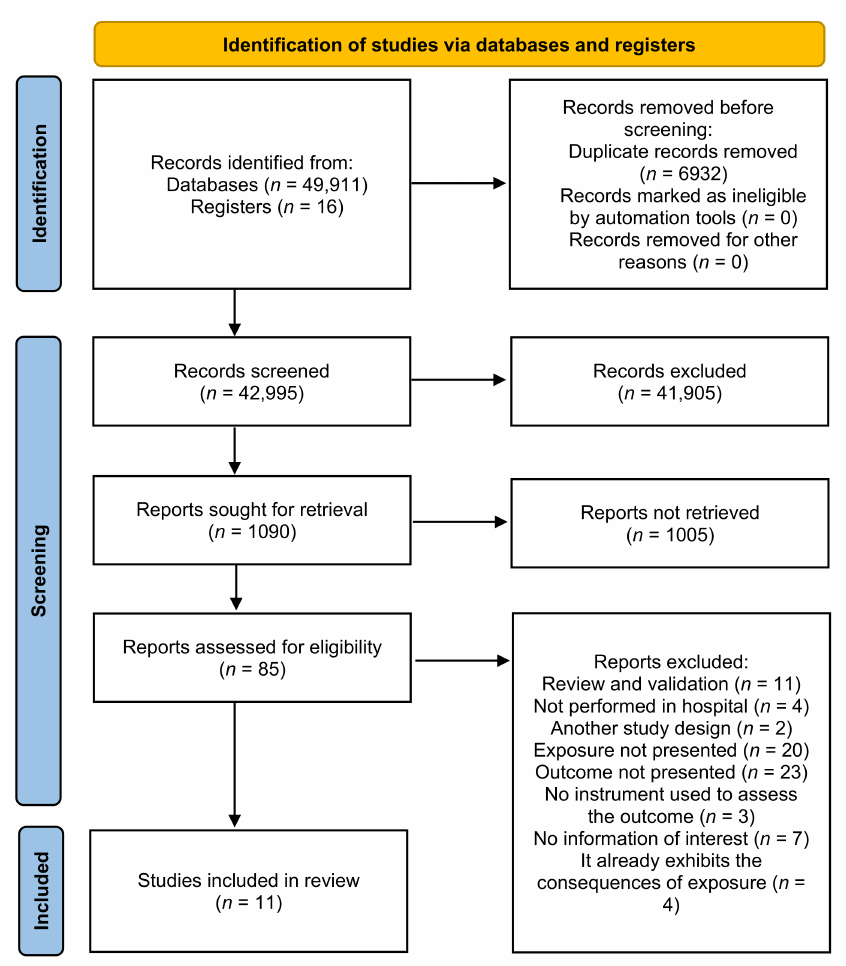
Figure 1. PRISMA flowchart of the study selection